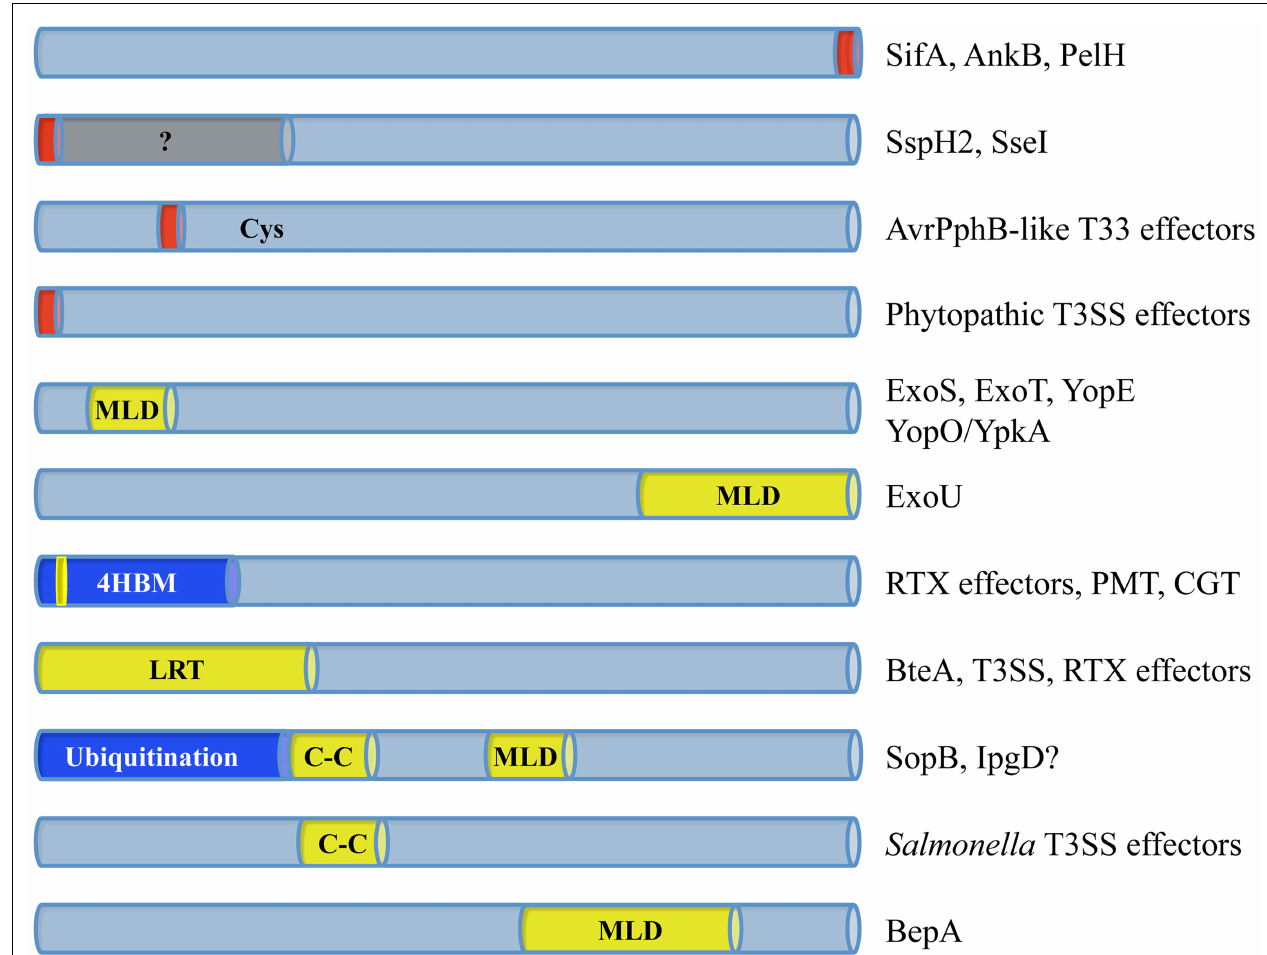
binding by generating electrostatic interactions or serving as sites for host cell ubiquitination. Sites for host cell lipidation (red) are also found at both termini as well as on the interior of certain effectors, which is exposed following cysteine protease cleavage. Several prenylated effectors contain motifs that provide additional targeting information (gray) to identify specific locations within the